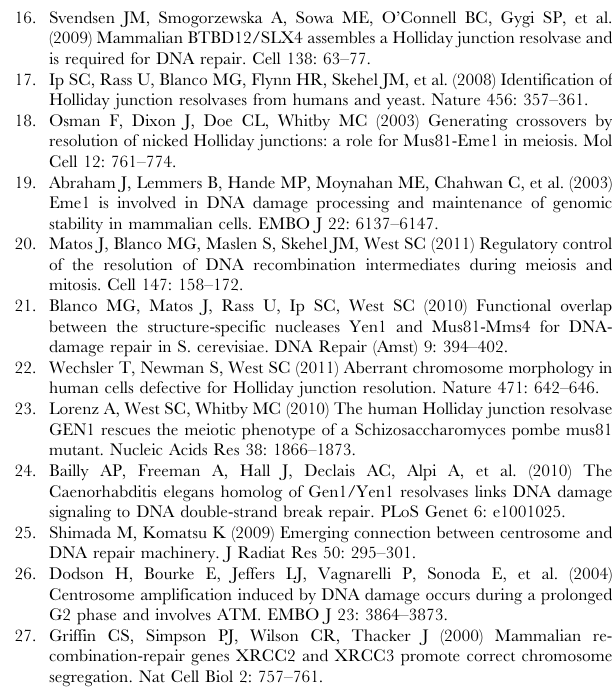
Figure S2 Human GEN1 localizes on the centrosome. A. Cells from the indicated cell lines were methanol fixed and co- immunostained with GEN1 and c -tubulin antibodies. DNA was visualized by DAPI. Bars: 10 m m. B. HeLa cells were methanol fixed and examined by immunefluorescence following co-immu- nostaining with different GEN1 antibodies (N-term 11-28aa and C-term 729–741aa) and c -tubulin. Scale bars, 10 m m C. HeLa cells were fixed with paraformaldehyde and immunostained with GEN1 antibody and DAPI. Scale bars, 10 m m. D. HeLa cells were treated with or without 0.04 ug/ml nocodazole and 14 h 892aa antibody) and a -tubulin antibody, or stained with GEN1 antibody and c -tubulin antibody. Scale bars, 10 m m. E. Sequence alignment of human cyclin E CLS with the putative CLS of GEN1 from various species. The red boxes indicate highly conserved amino acid, four of which were mutated to alanine in the GEN1 CLS-4A mutant Mm, Mus musculus; Rn, Rattus norvegicus; Dm, Drosophila melanogaster; Gg, Gallus gallus; Hs, Homo sapiens; Sc, Saccharomyces cerevisiae. Figure S3 GEN1 deficiency results in centrosome am- plification. A. HeLa cells were treated with CTRL or four different GEN1 siRNAs for 48 h, methanol fixed and co- immunostained with the indicated antibodies. B. Quantification of mitotic cells with . 2 mitotic spindles in the indicated cell lines 48 h after treatment with CTRL or GEN1 siRNA. The histogram shows the percentage of mitotic cells with . 2 mitotic spindles from three independent experiments. (n= 300 cells/condition/experi- ment) Scale bars, 10 m m. C. Western blot showing knock down efficiency in HeLa cells 48 h after siRNA transfection. D. HeLa cells were treated with CTRL or SLX4 siRNA for 48 h, methanol